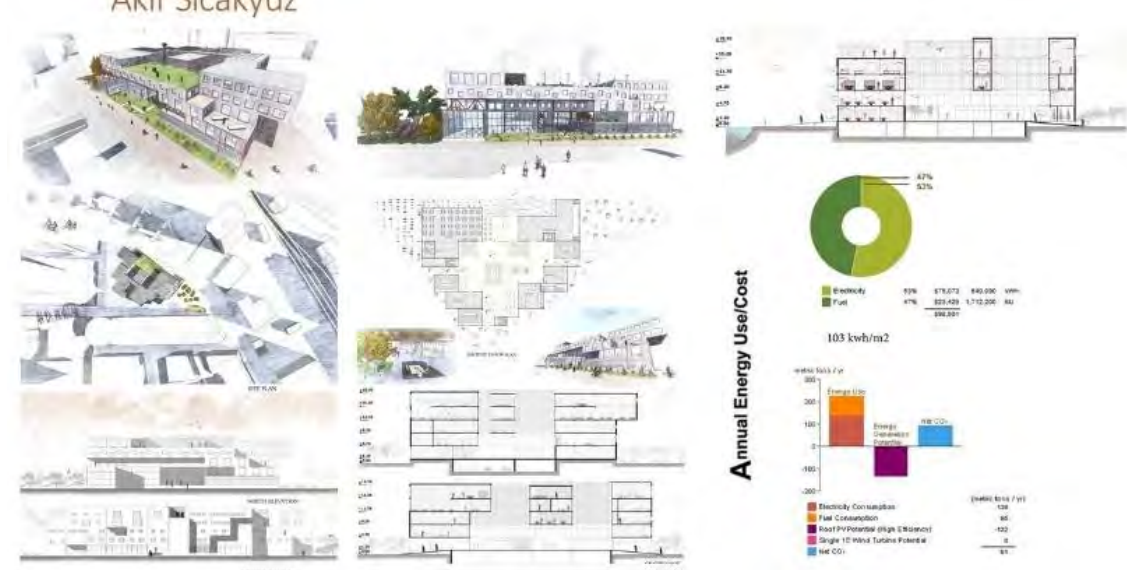
Figure 3. The designed Architecture department project in corporate the use of; natural light, green roof, natural ventilation, shading elements, collecting rain water, and solar panels.